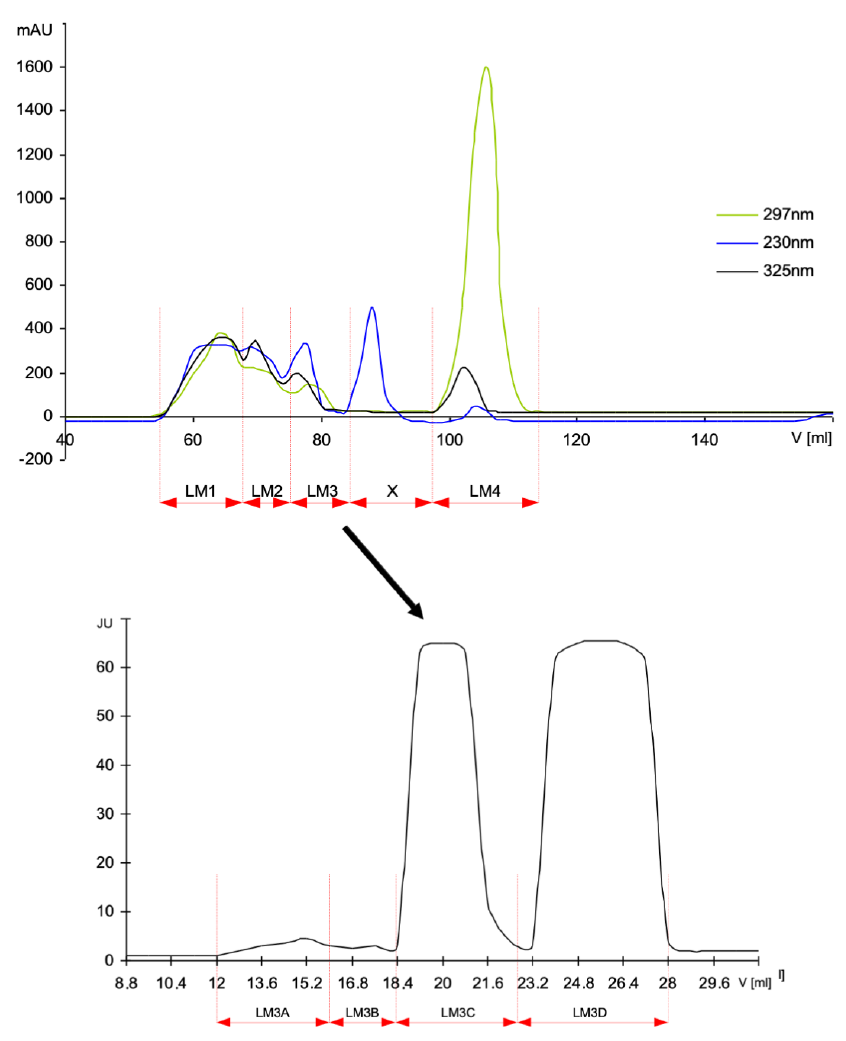
Figure 1. Chromatography on HW40S column in 0.1 M ammonium acetate of the LMW products formed from D-melibiose in reaction with N - α -acetyl-L-lysine, resulting in several fractions (upper panel), and the obtained fractions from the LM3 desalted on a Bio-Gel P-2 column (lower